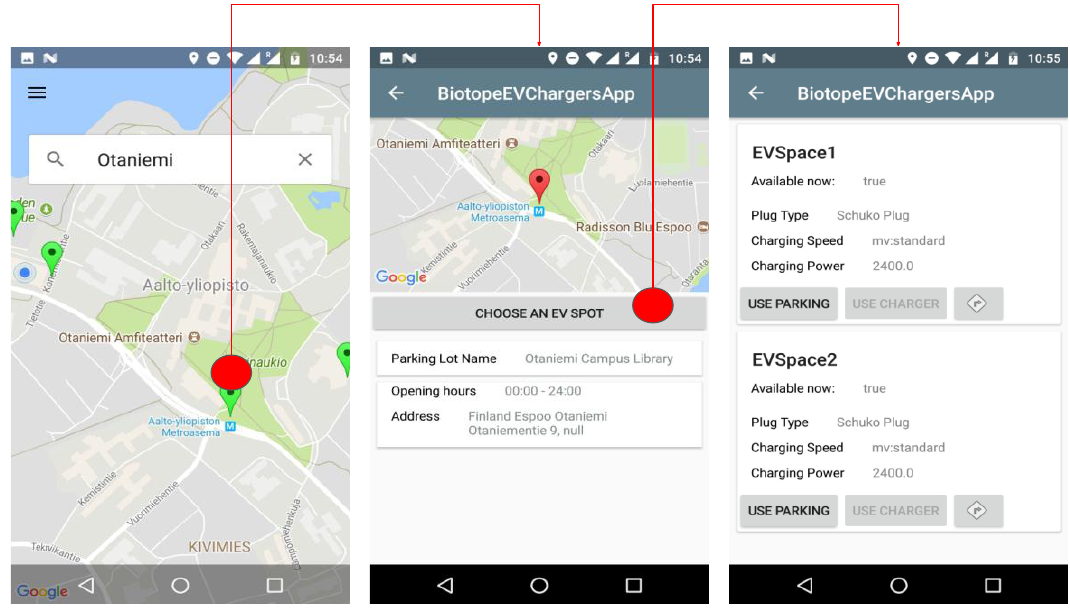
Figure 8. EV charging app UI.